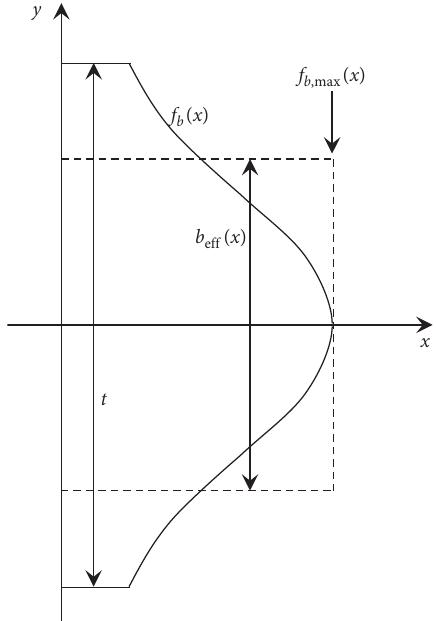
Figure 5: Longitudinal stress distribution at a section of an anchorage zone.